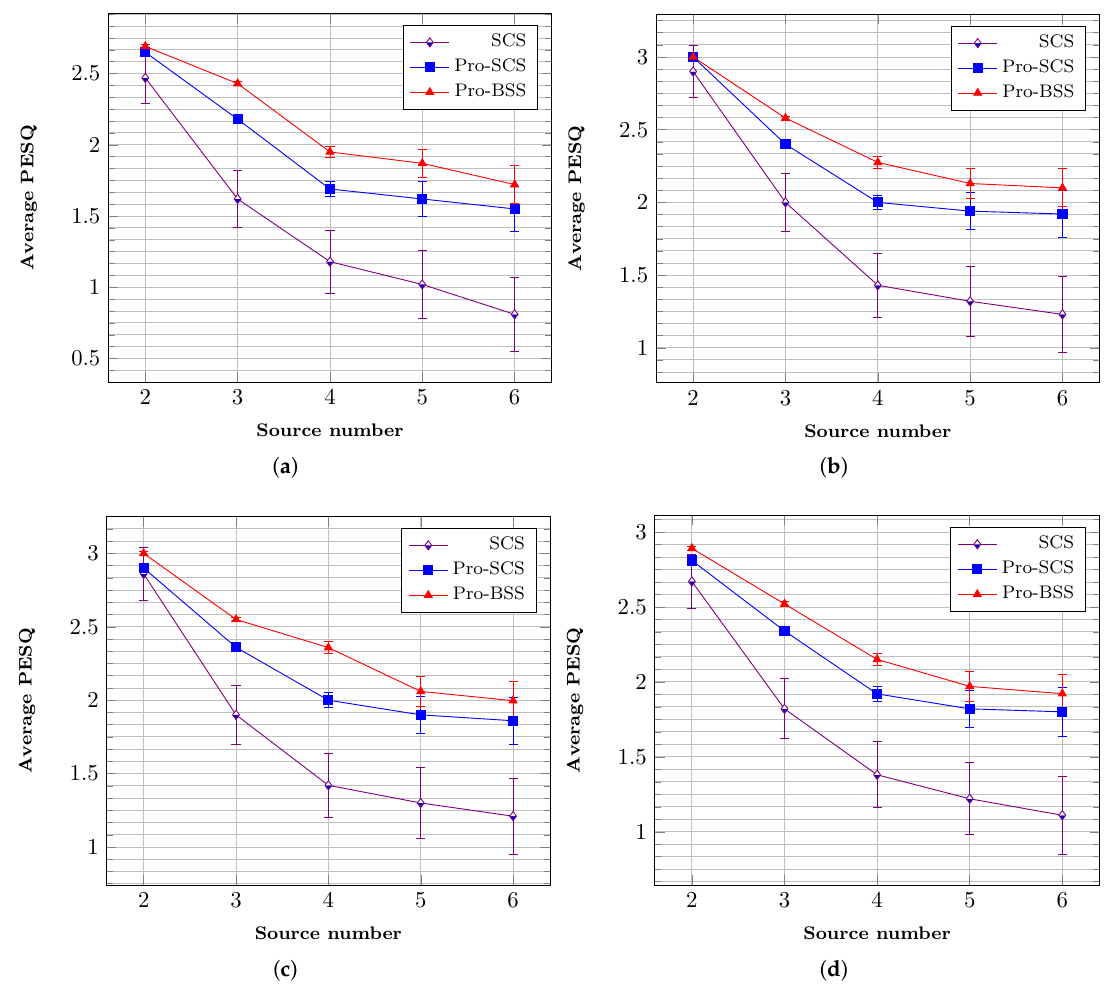
Figure 6. Perceptual evaluation of speech quality (PESQ) results. Error bars represent 95% confidence intervals; ( a – d ) represent the results for separations {30 ◦ , 40 ◦ , 50 ◦ , 60 ◦ }. SCS: sparse component separation; Pro-SCS: the proposed approach of sparse components with a dynamic threshold; Pro-BSS: the proposed sparse and non-sparse component separation